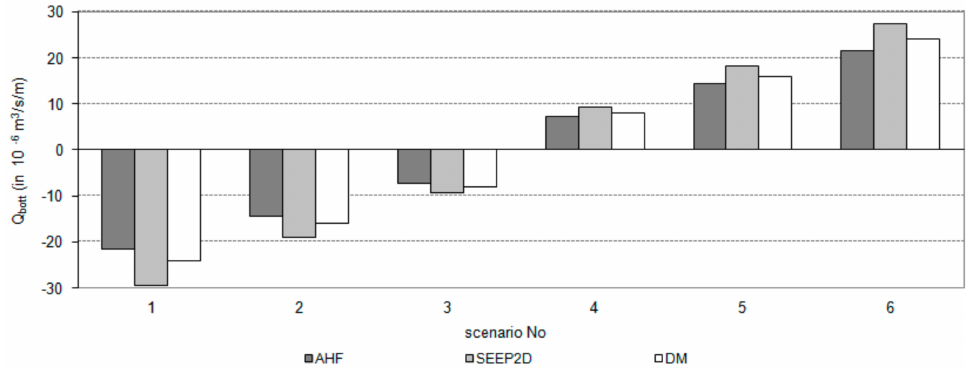
Figure 8. River bottom seepage for di ff erent scenarios and